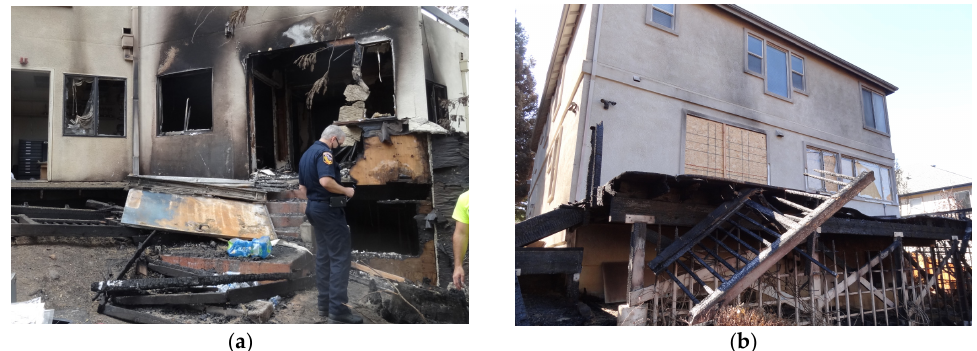
Figure 1. Examples of burning decks causing damage to the main structure of ( a ) a commercial wine-tasting room in Napa Valley and ( b ) a residential structure in Santa Rosa, California, during the 2020 Glass Fire. (Images taken during IBHS’s post-event investigation).